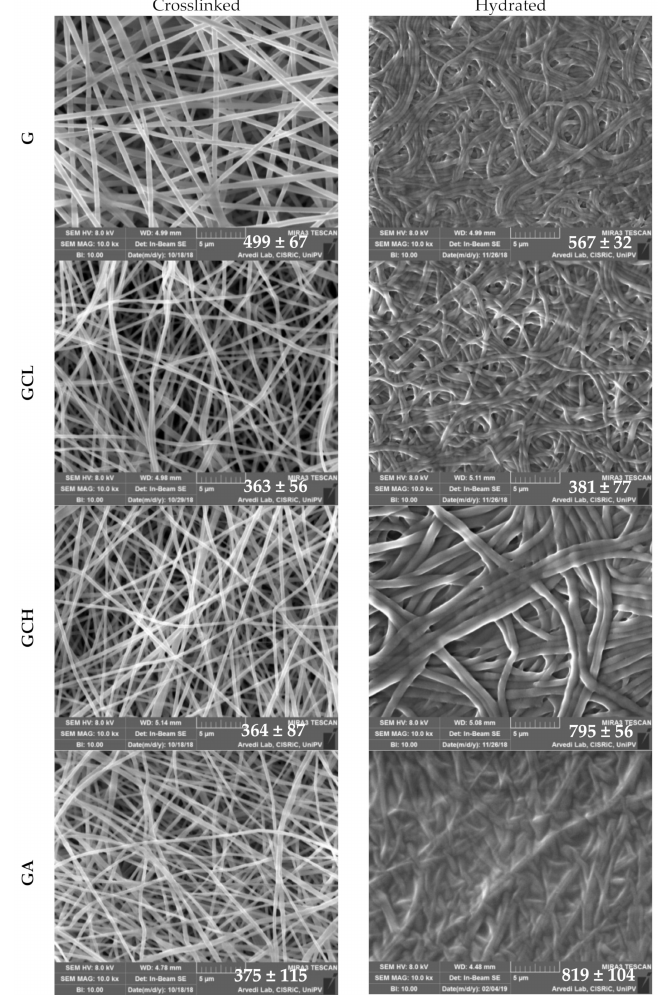
Figure 1. SEM microphotographs of scaffolds after cross-linking and after 20 days hydration in phosphate buffer solution (PBS). In each image, the diameters (nm) are reported (mean values ± sd; n = 100). ANOVA one-way; Scheff é test ( p < 0.05): crosslinked = gelatin (G) vs. GCL, GCH, GA; hydrated: GCL vs. GCH, GA. GCH: dry vs. hydrated; GA: dry vs.